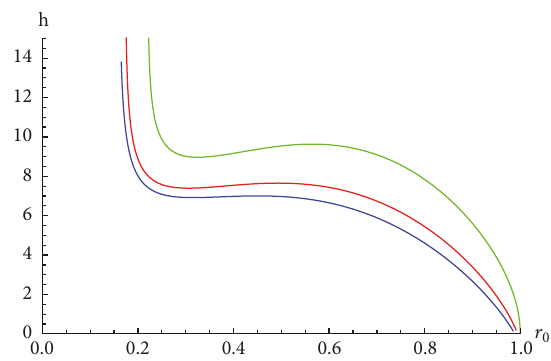
Figure 7: Relation between ℎ and 𝑟 0 for the case 𝑟 = 0.2,𝑟 ℎ = 1 . The green line, red line, and blue line correspond to 𝑄 = 0.5, 0.52, 0.54 , respectively.